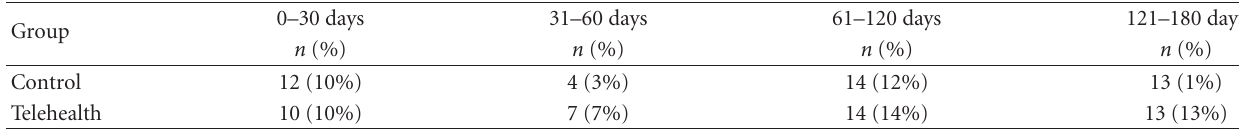
Table 9: Number and percent of ED visits by time period and group.